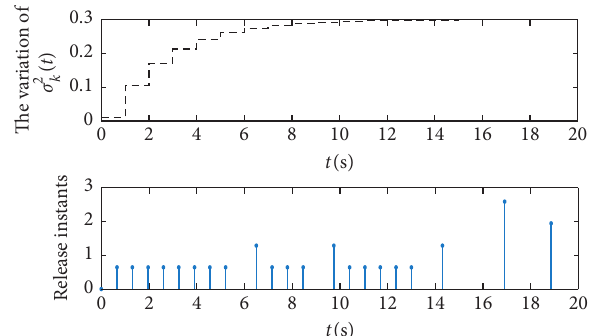
Figure 4: The parameter σ 2